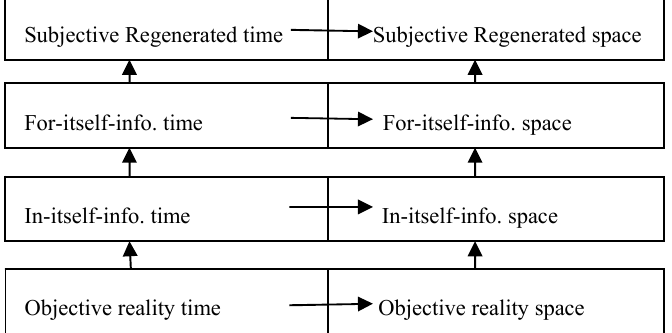
Figure 1. The Spatialization mechanism of time from the perspective of Information